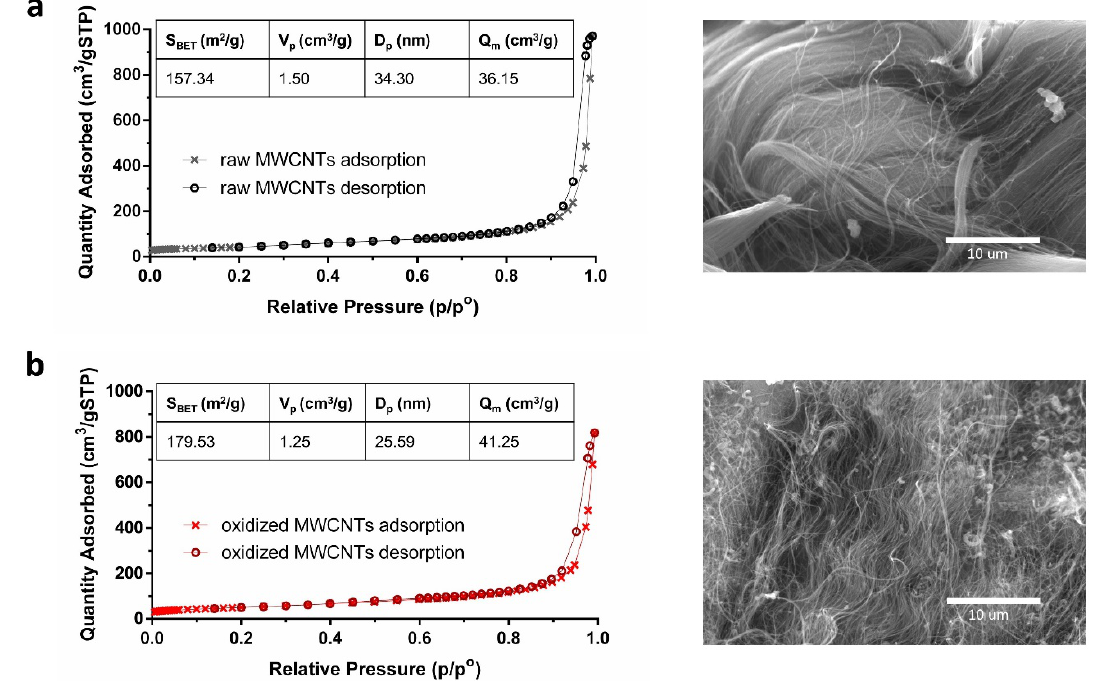
Figure 1. BET adsorption-desorption profiles and SEM images for ( a ) raw MWCNTs and ( b ) oxidized MWCNTs. S BET : BET surface area; V p : pore specific volume; D p : pore diameter; Q m : maximum adsorption capacity.